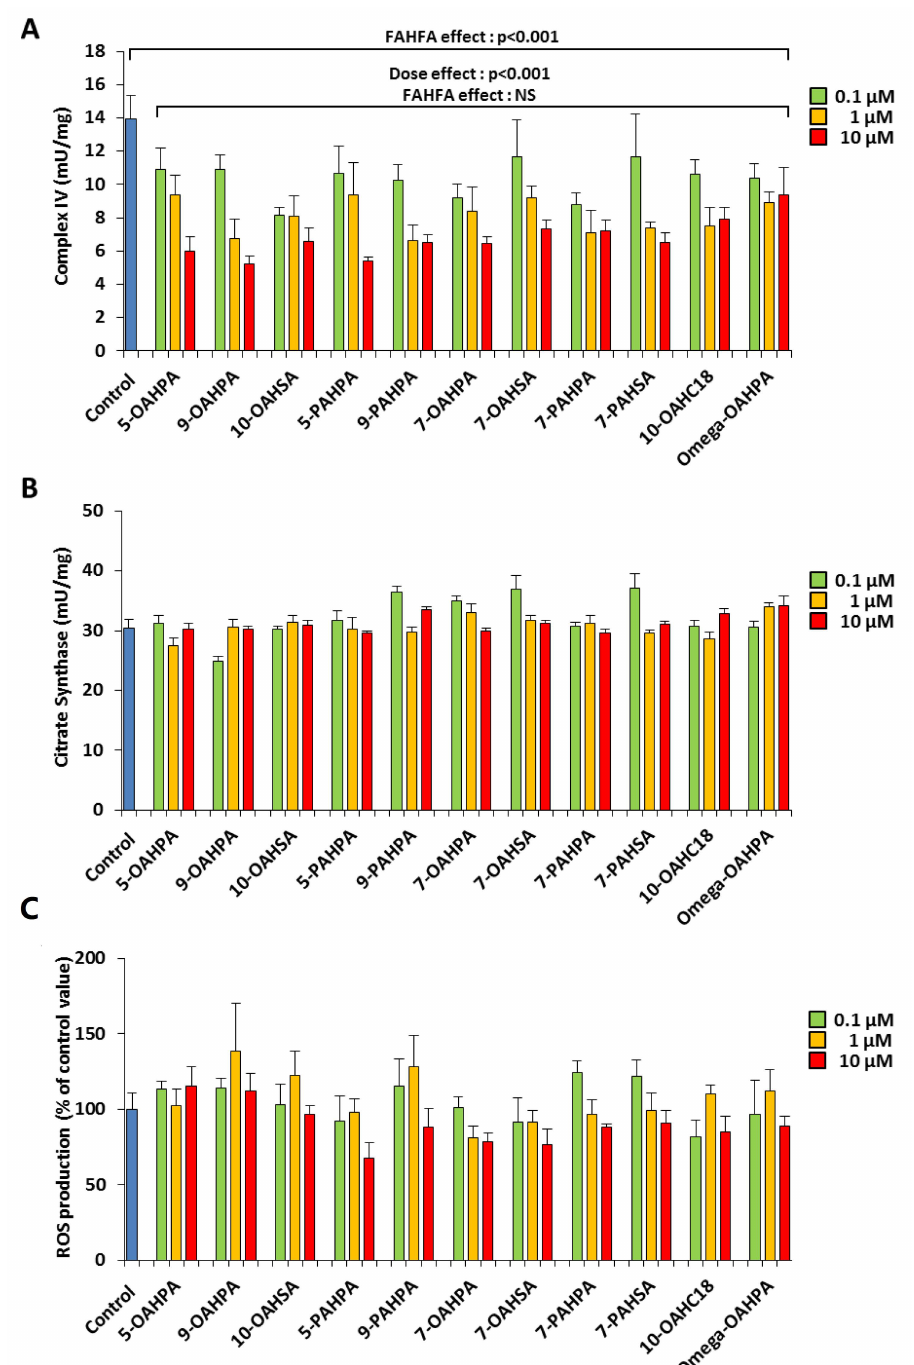
Figure 3. FAHFAs decreased mitochondrial respiratory chain activity in proliferating C2C12 myoblasts. ( A ) FAHFAs decreased mitochondrial complex IV activity in proliferating C2C12 myoblasts. Enzymatic activity was measured 24 h after FAHFA treatment at the indicated concentration ( n = 6 for each group). ( B ) FAHFAs had no influence on citrate synthase activity in proliferating C2C12 myoblasts. Enzymatic activity was measured 24 h after FAHFA treatment at the indicated concentration ( n = 6 for each group). ( C ) FAHFAs had no influence on ROS production in proliferating C2C12 myoblasts. ROS accumulation was measured using the H2DCF-DA probe 24 h after FAHFA treatment at the indicated concentration ( n = 6 for each group). The e ff ect on the groups, including the control group, was tested by one-way ANOVA, followed up by a Fisher’s least significant di ff erence (LSD) test; all the groups, except the control group, were also tested for the e ff ects of dose, FAHFAs, and their interaction by two-way ANOVA test. Results are expressed as means ±